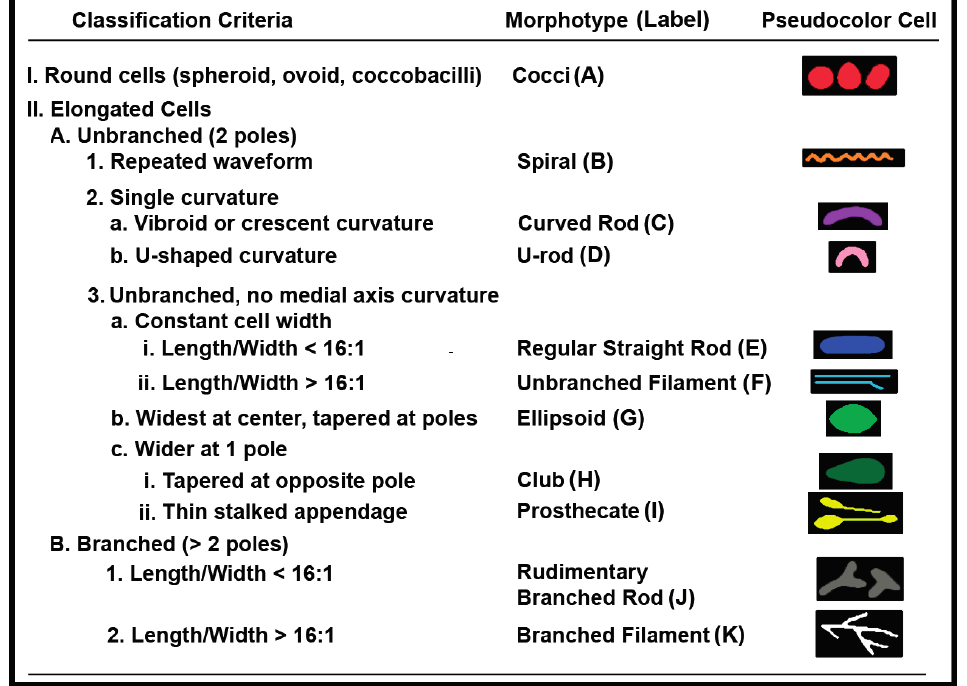
Figure 1. Visual characteristics of microbial morphotypes classified by CMEIAS (Center for Microbial Ecology Image Analysis